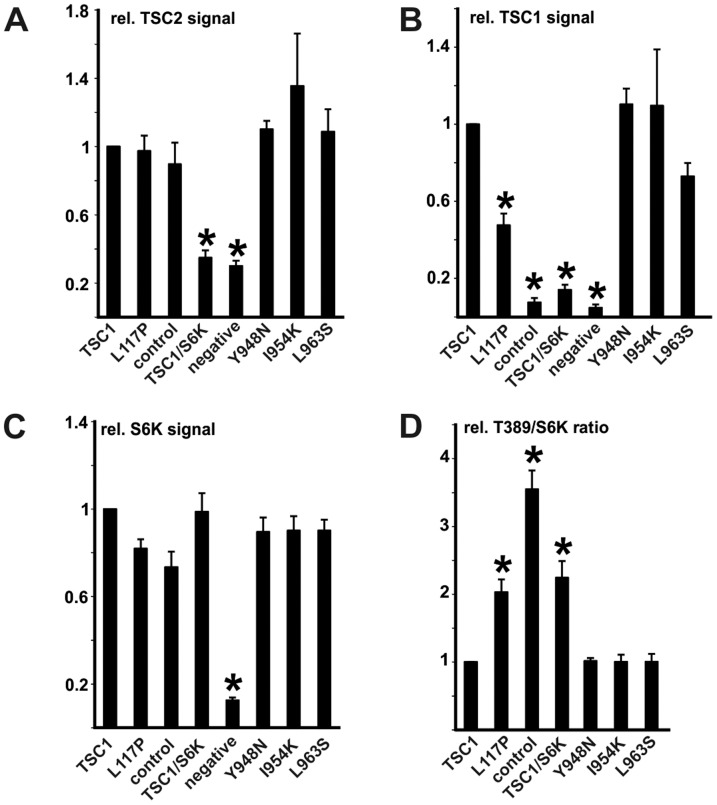
Assessment of the effects of the TSC1 Y948N, I954K and L963S variants on TORC1 signaling.The TSC1 variants were coexpressed in transfected HEK 293T cells with TSC2 and S6K. TSC2, TSC1, S6K and T389-phosphorylated S6K (T389) signals were estimated by immunoblotting. The TSC1 variants were compared to wild-type TSC1, the pathogenic TSC1 L117P variant, cells expressing TSC2 and S6K only (control), cells expressing TSC1 and S6K only and mock transfected cells (negative) in at least 3 independent experiments. The integrated intensities of the immunoblot signals for TSC2 (A) TSC1 (B) total S6K (C) and the T389/S6K ratio (D) were calculated relative to wild-type TSC1 (TSC1; = 1). Significant differences (unpaired t-test p values<0.05) are indicated with asterisks. Error bars indicate the standard error of the mean. No significant differences between wild-type TSC1 and the TSC1 Y948N, I954K or L963S variants were detected.